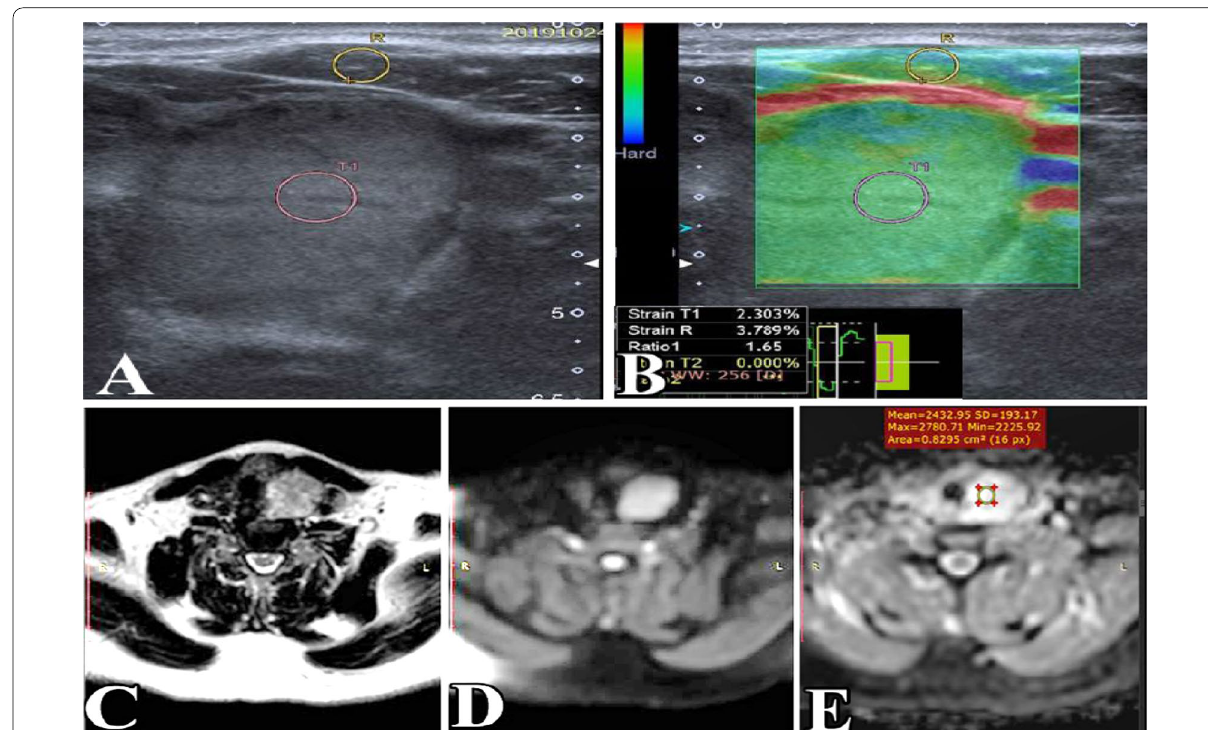
Fig. 1 Female patient aged 58 years presented with left thyroid lobe nodule. Ultrasound features of the nodule A : The left thyroid lobe shows a solid isoechoic nodule, wider more than taller with smooth outline. No calcifications. TIRADS categorization: TIRADS (3). On elastography color map B : no deep blue areas could be detected. Elastography score: (1). Strain ratio intermediate signal intensity. Diffusion weighted images D : the nodule shows high signal intensity. ADC mapping E : it shows high signal with ADC value 2.43 10 − 3 . Pathology: Hurthle cell = ×